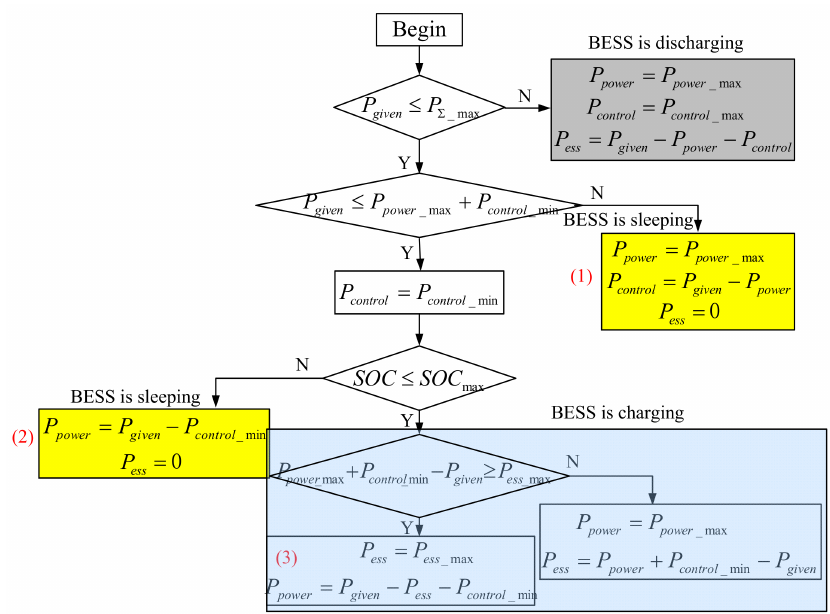
Figure 4. Block diagram of the power